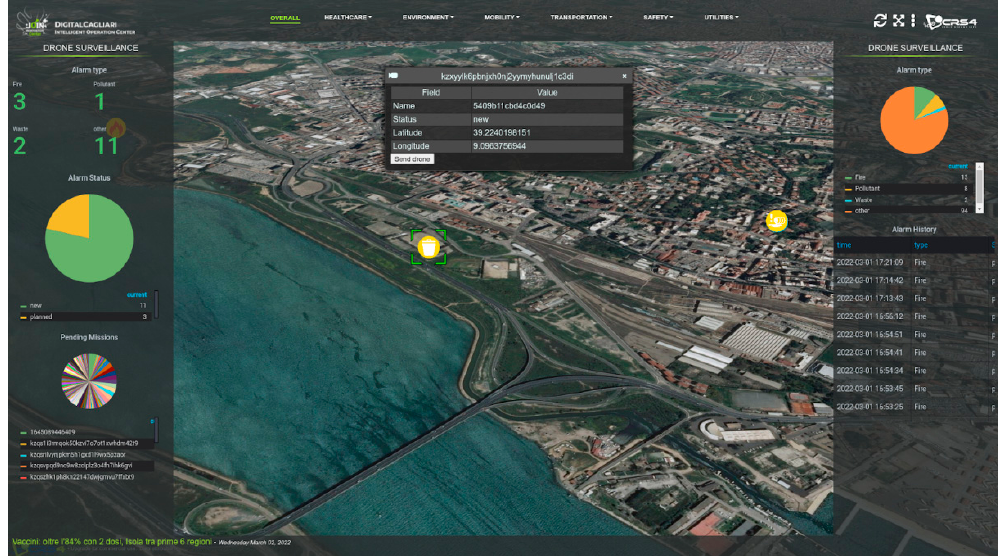
Figure 5. One of the new alerts (about illegal dumping ) is selected on the 3D satellite map, along with the widget where a button allows the decision-maker to require an inspection by drone.